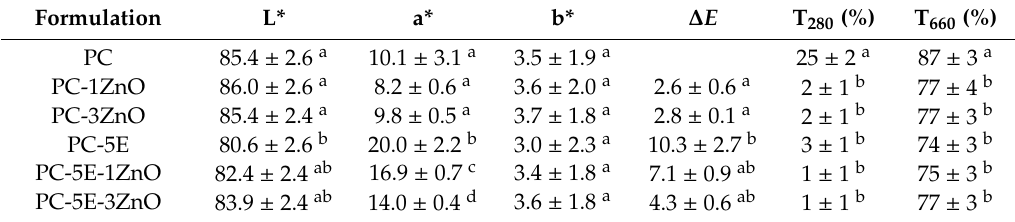
Table 3. Colour parameters and transparency of pectin-based